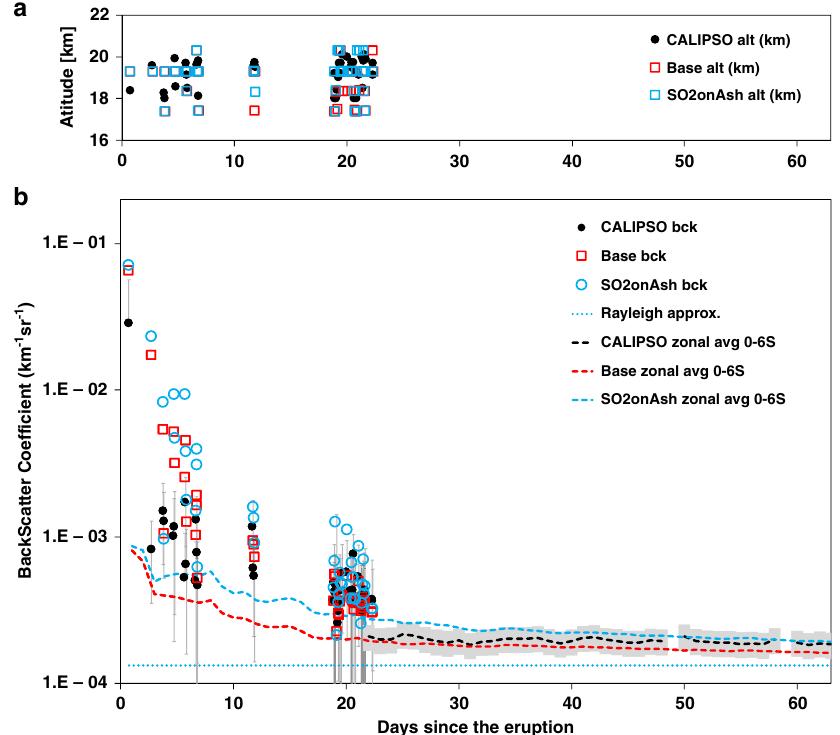
Fig. 3 the volcanic ash layer altitudes and the total backscatter coef fi cient. a the volcanic ash layer altitudes from CALIPSO and two model cases. b The total backscatter coef fi cient (aerosol + Rayleigh). We pick the largest total backscatter in the vertical pro fi les and its corresponding altitude on the selected segments to de fi ne the altitudes in panel a and the values in ( b ) (dots and circles). The dashed lines are the zonal average backscatter from CALIPSO (black) and two model cases (red and blue). CALIPSO does not have observations from 21 Feb to 23 Feb and from 25 Feb to 2 March. The blue dotted line represents the approximate background backscatter from air plus the background sulfate aerosol. The gray error bars represent the standard deviation of the dotted CALIPSO data. The gray shaded area shows the modeled average values are within 20% of CALIPSO averaged values. The standard deviation of the CALIPSO zonal average values is over a factor of